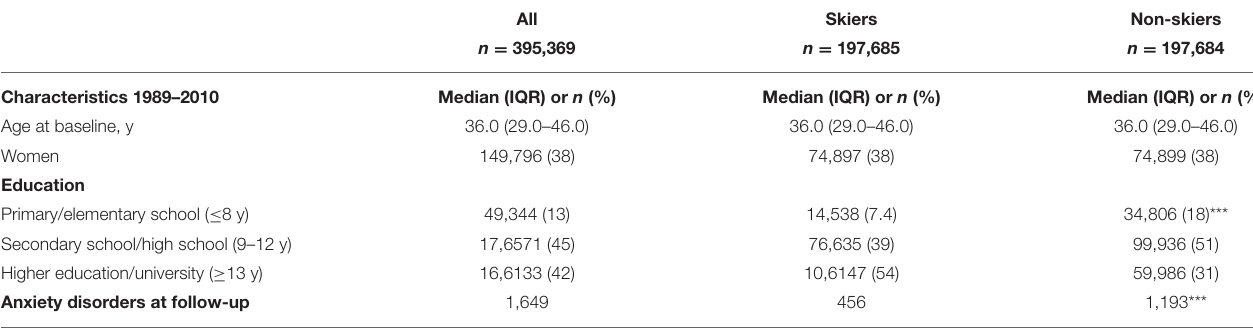
TABLE 1 | Characteristics of the study population, presented for the whole cohort, and by skiers and non-skiers separately.